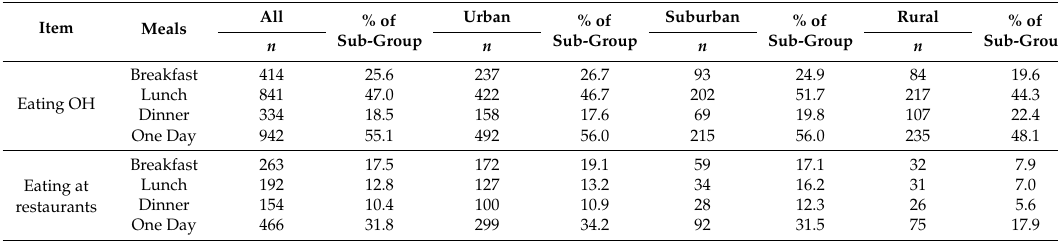
Table 2. Frequency of eating OH and restaurant meals of adults living in urban, suburban, and rural areas.